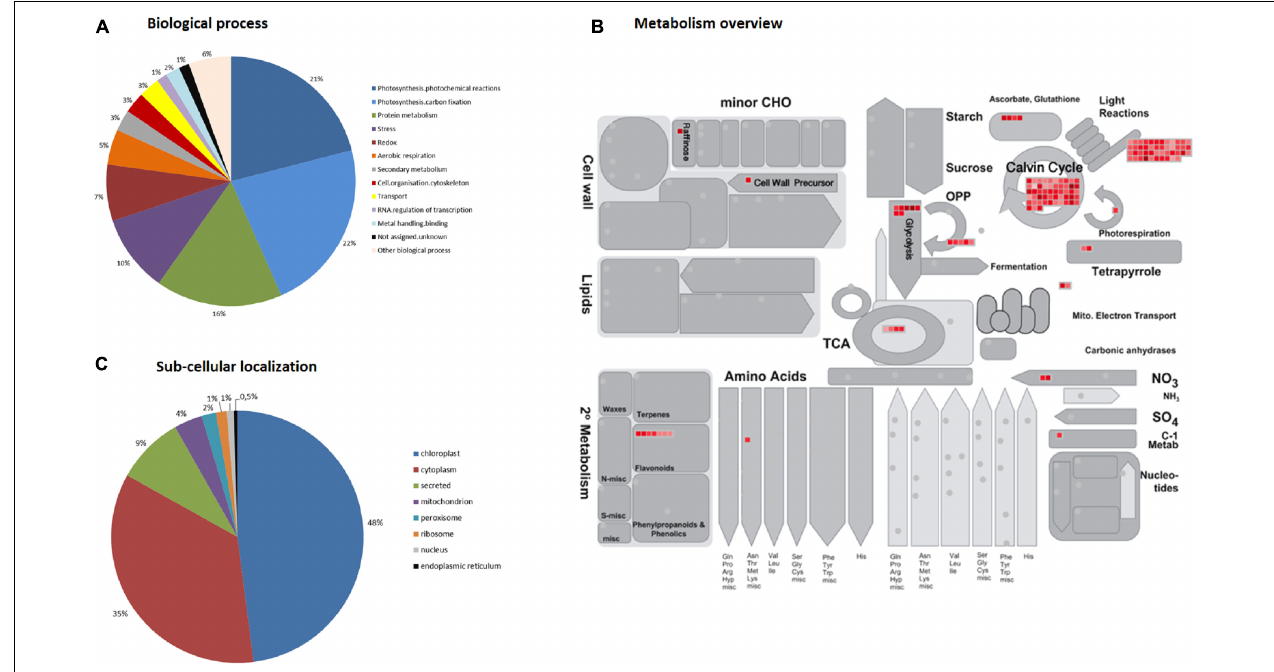
FIGURE 2 | Functional annotation of the 219 identified coffee leaf proteins based on MapMan “Bin” and GO ontology. (A) Biological process; (B) Metabolism overview; (C) Sub-cellular localization.